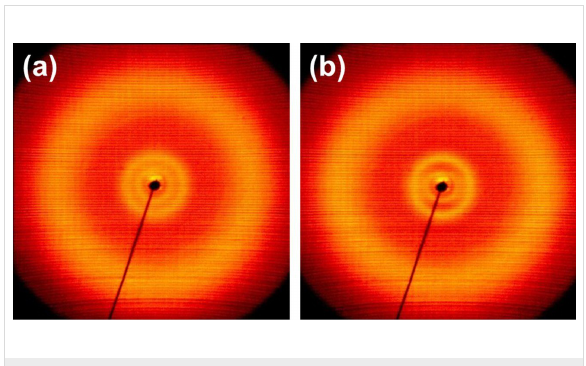
Figure 5: 2D X-ray patterns for 1d: (a) isotropic liquid at 160 °C, (b) partially aligned liquid crystalline phase at 120 °C on cooling. The magnetic field is parallel to the meridian of the